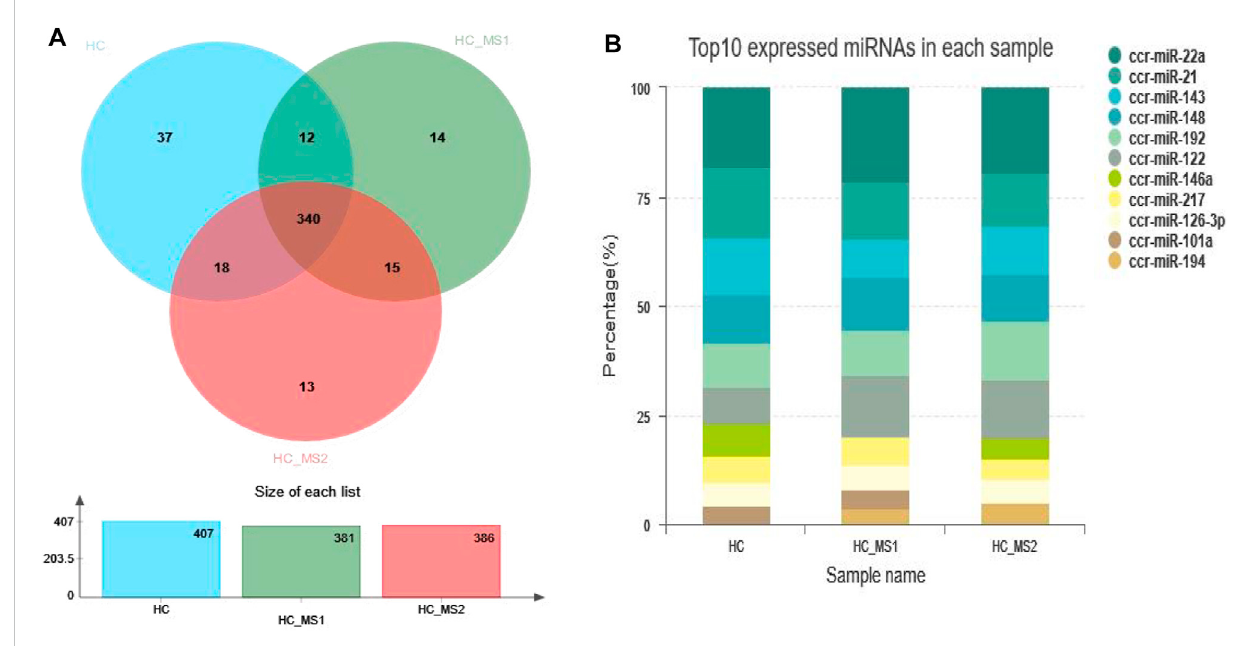
FIGURE 2 Sequence quantity of known miRNAs and the 10 known miRNAs with the most abundant expression in three libraries (n =